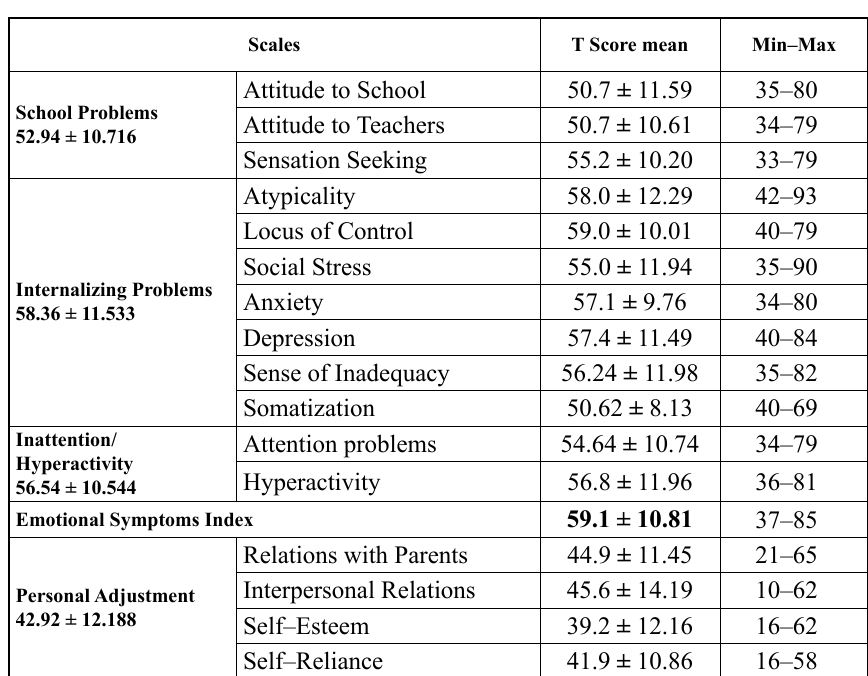
Table 2. Average scores of the Emotional Behaviour scale of girls with delinquent